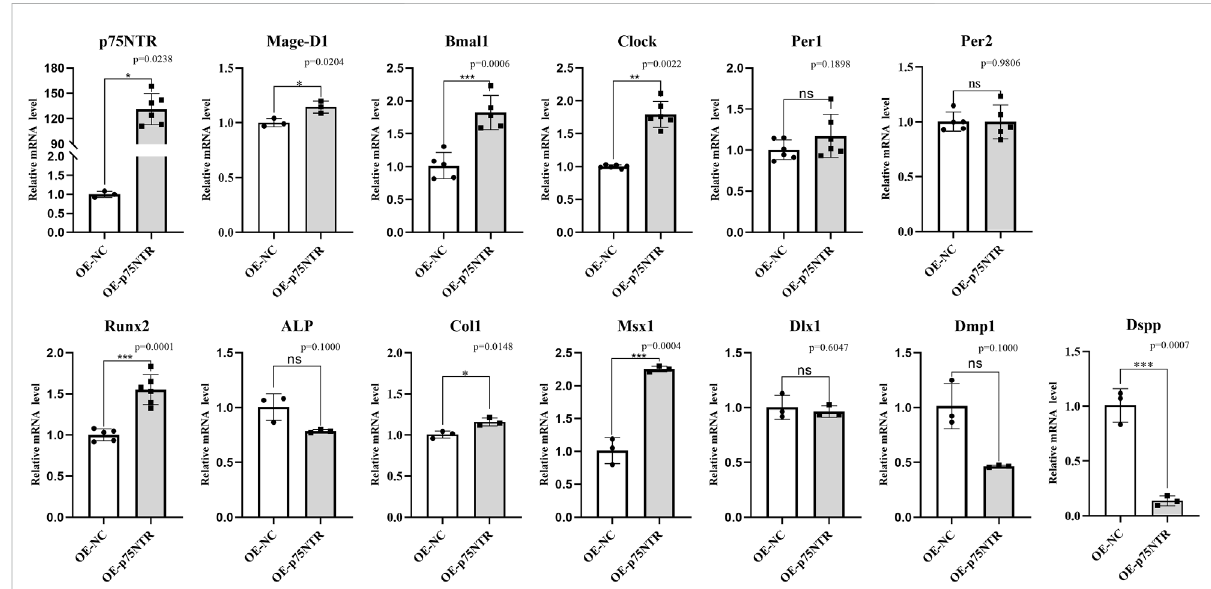
FIGURE 7 The in vitro assays for the effect of p75NTR over-expression on the mRNA expression in immortalizing stem cells from dental apical papilla (iSCAP). p75NTR was expected to be signi fi cantly higher expressed in the over-expression group than that in the control group ( p < 0.05). Mage-D1 , Bmal1 , Clock , Runx2 , Col1 , and Msx1 showed an apparent positive relationship when p75NTR was signi fi cantly up-regulated. In contrast, ALP , Dmp1 , and Dspp showed a negative relationship with p75NTR . Per1 , Per2 , ALP , Dlx1 , and Dmp1 showed no signi fi cant difference between the over- expression group and control group ( p > 0.05) with lower than that in wild-type mice ( p < 0.05). All experiments were repeated at least three times independently. Data are expressed as mean ± S.D. Overexpression negative control group, n = 3; p75NTR over-expression group, n =